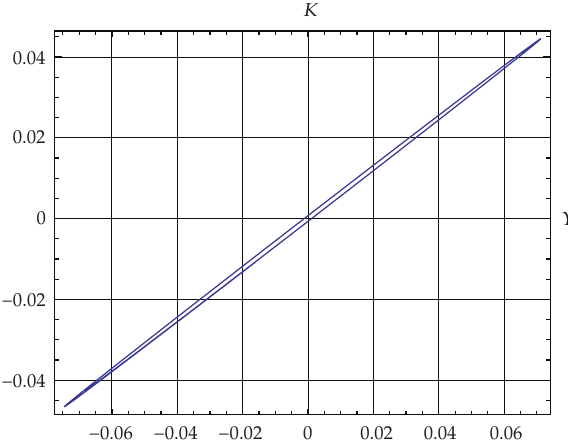
Figure 2: A stable periodic orbit is generated when (cid:5) μ 1 ,μ 2 (cid:6) is located in the region between H and P .